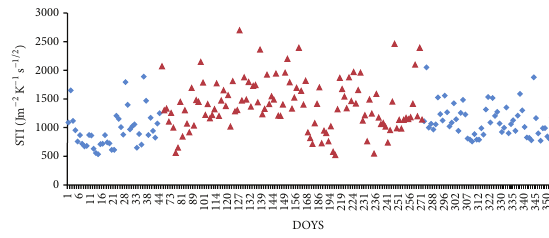
Figure 3: Temporal variations of soil thermal